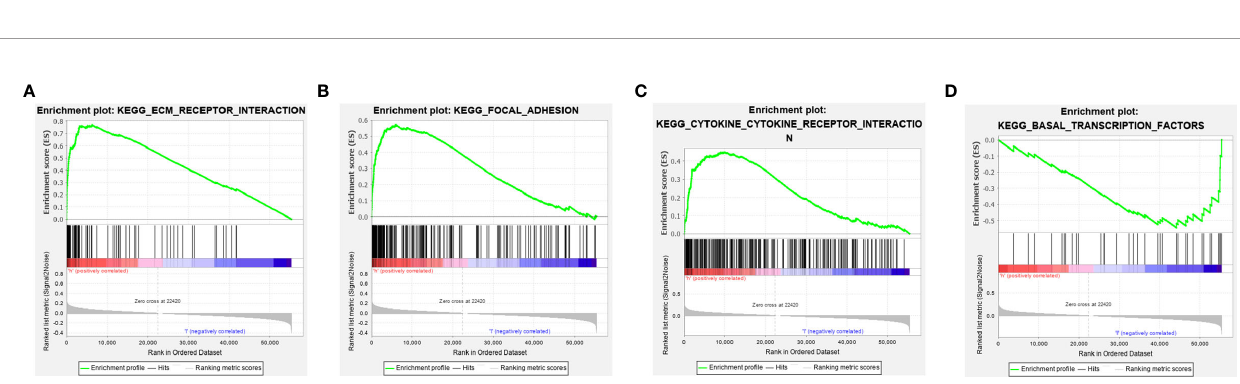
FIGURE 6 | Validation of the independence of the m6A-related lncRNA signature in OS through the Univariate cox regression analysis (A) and Multivariate cox regression analysis (B) .